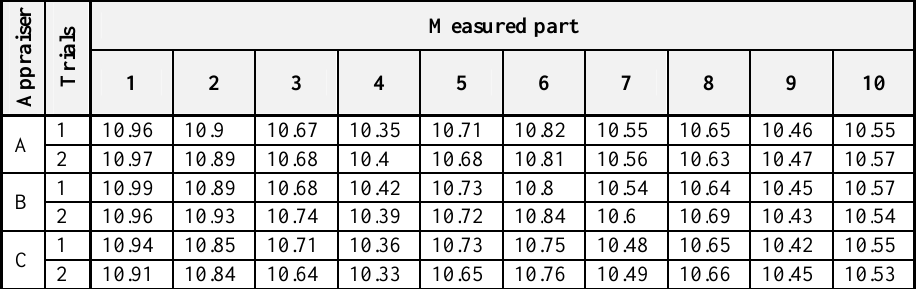
Table 1 Measured data of nuts height, mm (Plura,